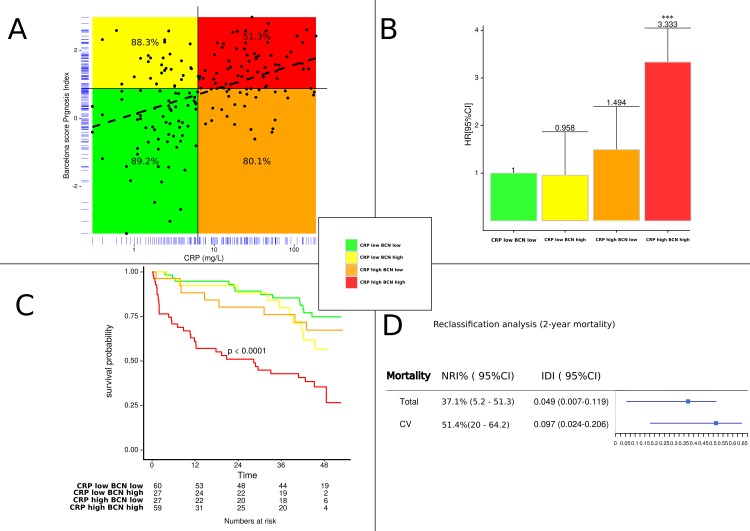
Association of ST2 with Barcelona score levels dichotomized as high or low according to the median of each biomarker (A) Correlation analysis with survival rate, (B) Adjusted hazard ratio of death according to combined criteria as median of ST2 and Barcelona score (C) Kaplan Meier curves for all-cause mortality according to combination of median of ST2 and Barcelona score and (D) Reclassification of two years risk of death for all cause or cardiovascular (CV) mortality. NRI and IDI values were reported when CRP was added to the clinical model in combination with high BCN value. NRI: net reclassification index; IDI: integrated discrimination index; BCN: Barcelona bio-heart failure risk calculator (BCN Bio-HF calculator).